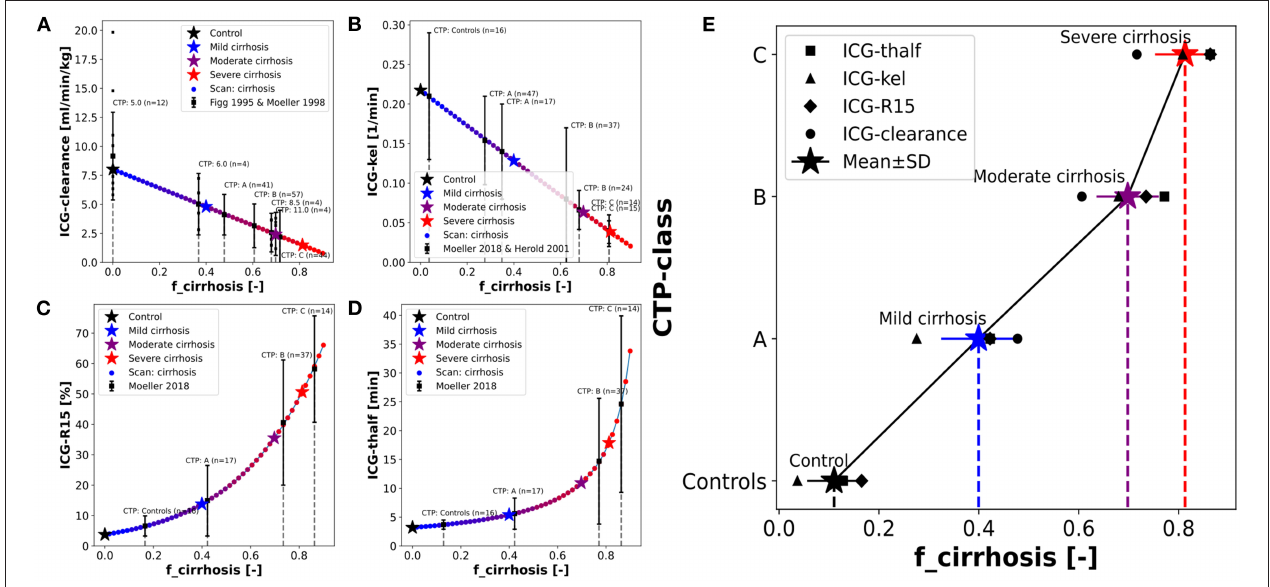
FIGURE 5 | Mapping of model cirrhosis degree on CTP-score. (A) Mapping based on ICG clearance (Figg et al., 1995; Møller et al., 1998). (B) Mapping based on ICG-kel (Herold et al., 2001; Møller et al., 2019). (C) Mapping based on ICG-R15 (Møller et al., 2019). (D) Mapping based on ICG-thalf (Møller et al., 2019). (E) Resulting f cirrhosis values for each CTP-class combining the information from the mappings based on individual ICG pharmacokinetic parameters (Control: f cirrhosis = 0.0; Mild cirrhosis: 0.41; Moderate cirrhosis: 0.70; Severe cirrhosis: 0.82).